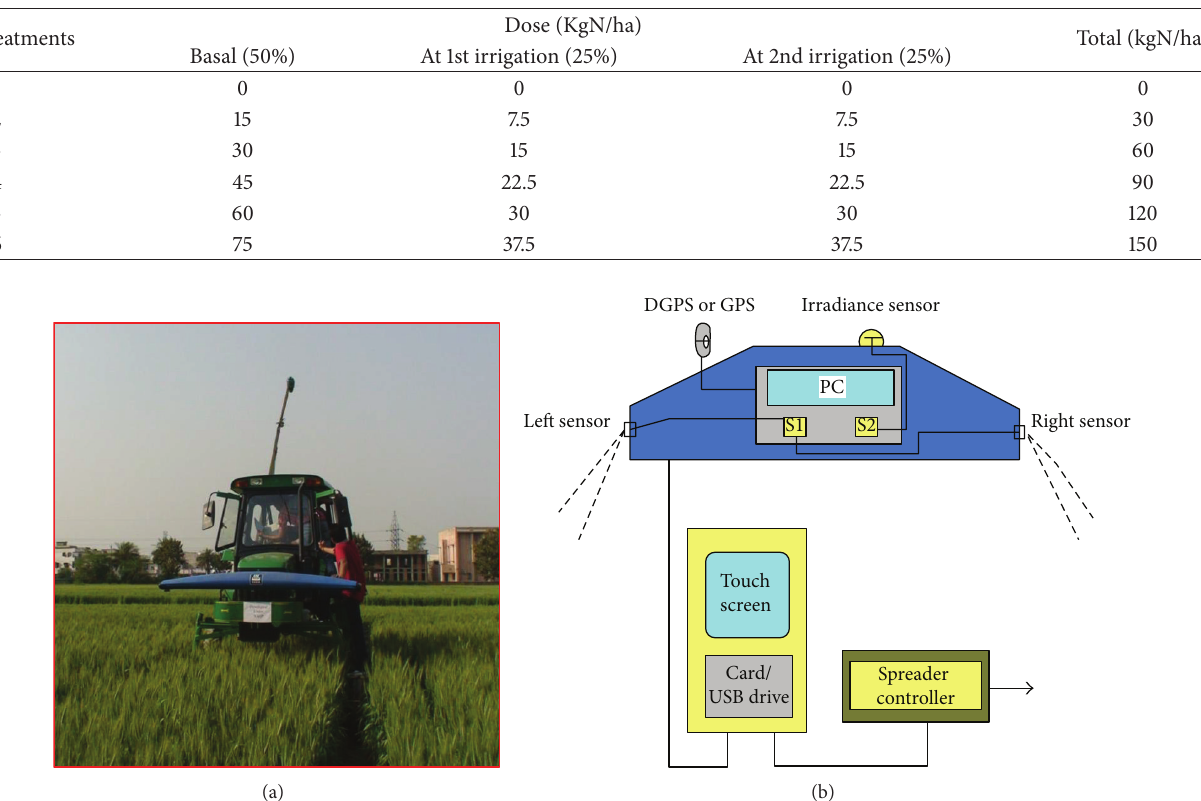
Figure 2: N-sensor (a) in wheat crop installed over the multiutility high clearance vehicle, (b) different parts with setup.